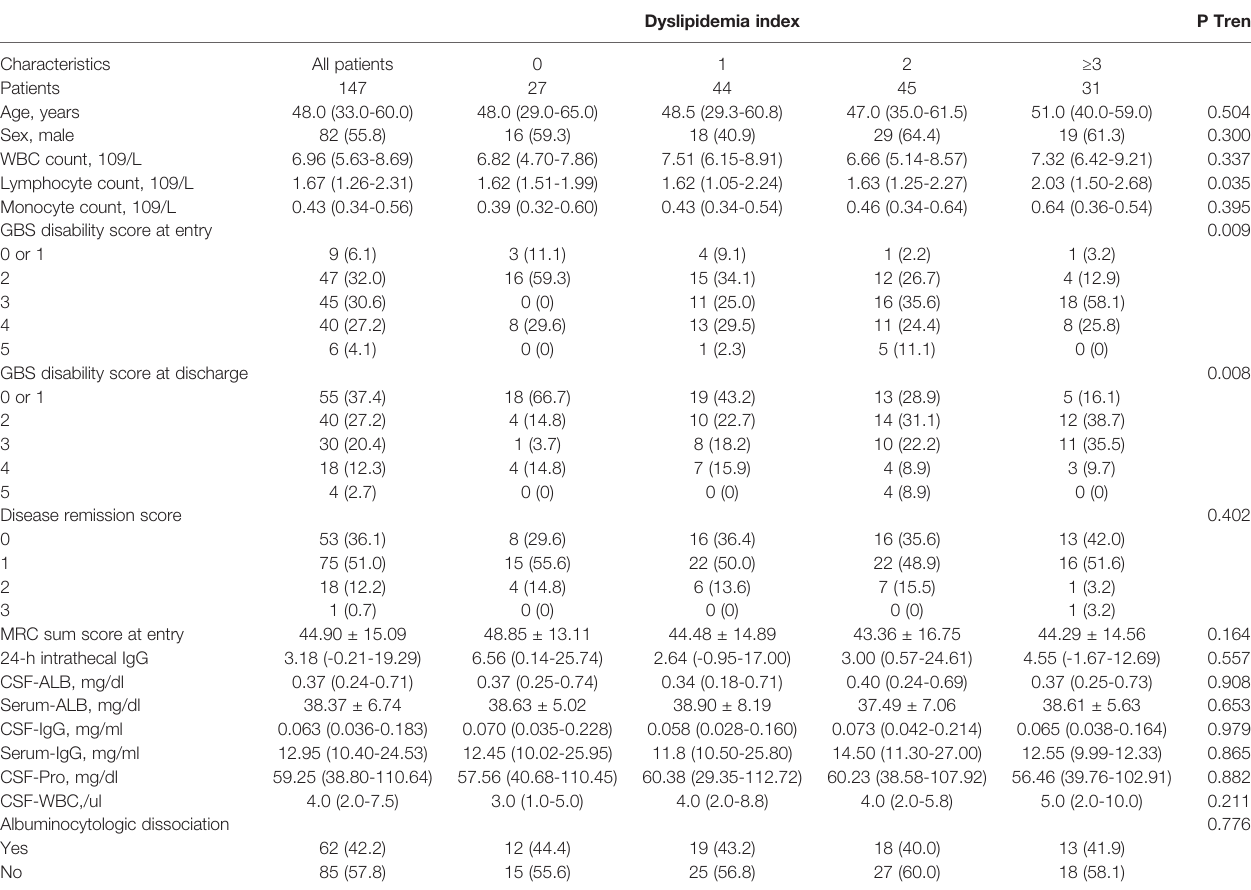
TABLE 4 | Characteristics of Patients with GBS According to Dyslipidemia Index.